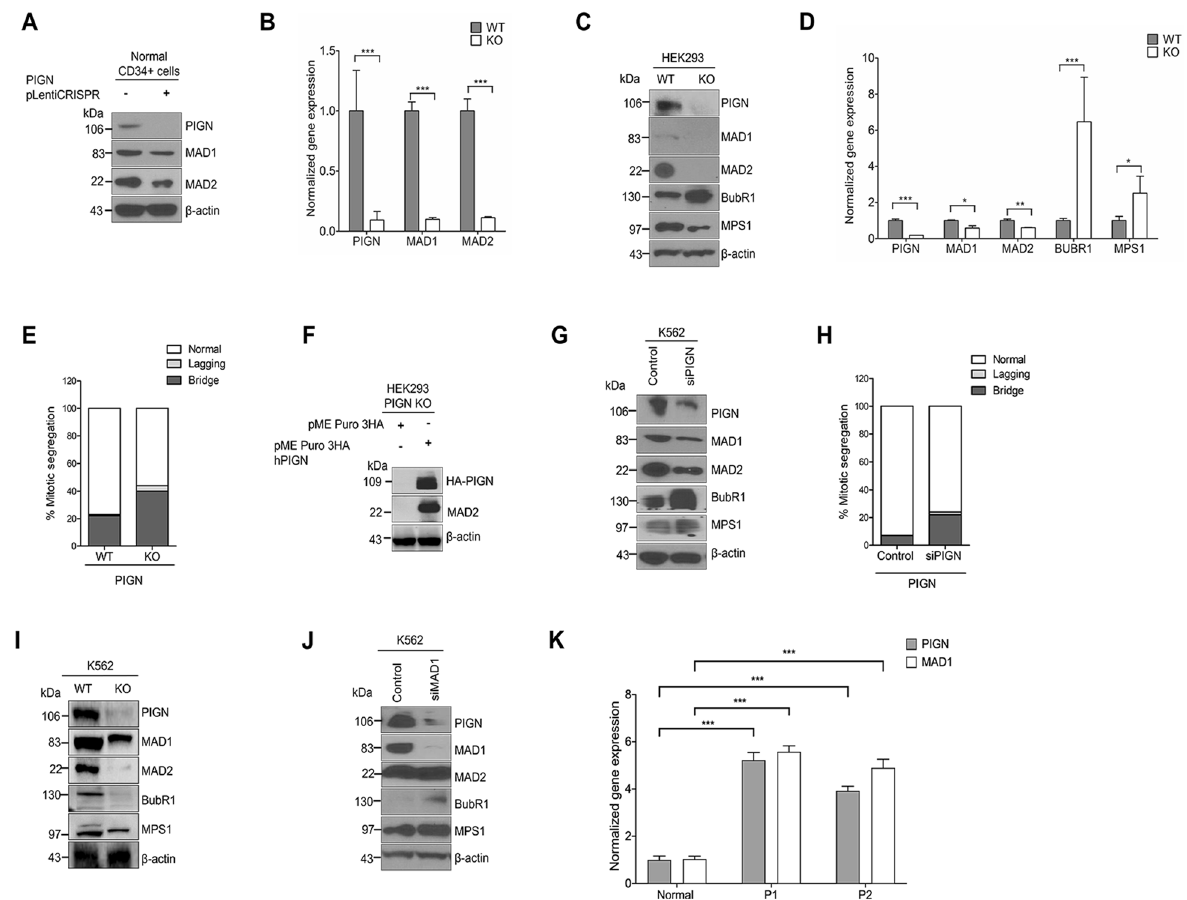
Figure 2. PIGN loss or suppression results in the differentially disrupted expression of SAC components. ( A ) CRISPR/Cas9 ablation of PIGN led to MAD1 and MAD2 downregulation in CD34+ mononuclear cells from a healthy donor. ( B ) Gene and protein expressions of MAD1 and MAD2 were significantly (*** p < 0.0001) impacted by PIGN loss in CD34+ mononuclear cells from a healthy donor. ( C , D ). Complete loss of PIGN via CRISPR/Cas9 ablation (KO) was associated with downregulation of MAD1, MAD2, and MPS1 while causing an upregulated gene (*** p < 0.0001) and protein expression of BUBR1 in HEK293 cells. PIGN loss resulted in significant repression (* p < 0.05) of MAD1 and MAD2 gene expression but led to MPS1 gene upregulation (* p < 0.05). ( E ) PIGN loss (KO) increased the frequency of segregation errors in HEK293 cells. ( F ) Ectopic overexpression of PIGN restored MAD2 expression in HEK293 PIGN KO cells. ( G ) RNAi-mediated PIGN suppression resulted in MAD1 and MAD2 downregulation but increased expression of BUBR1 and MPS1 expression in K562 cells. ( H ) MAD1 suppression was accompanied by a corresponding decrease in PIGN protein expression in K562 cells. ( I ) CRISPR/Cas9 ablation of PIGN (K562 KO) resulted in MAD1,